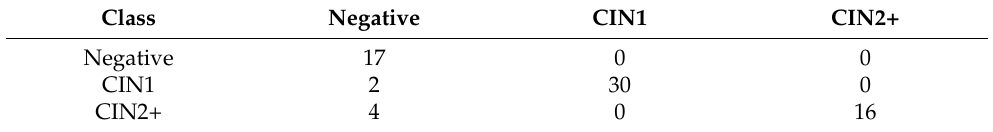
Table 4. Confusion matrix showing classification of negative, CIN1 and CIN2+ samples from the test set.